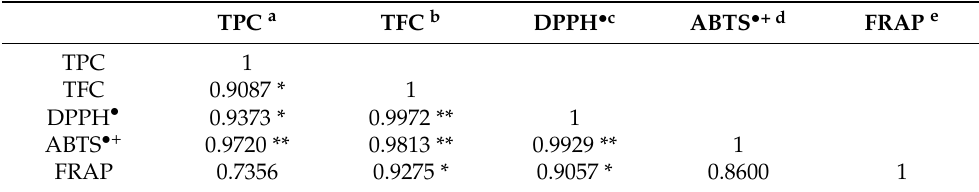
Table 5. Pearson correlation matrix between phytochemical contents and antioxidant activities of A. foeniculum extracts.